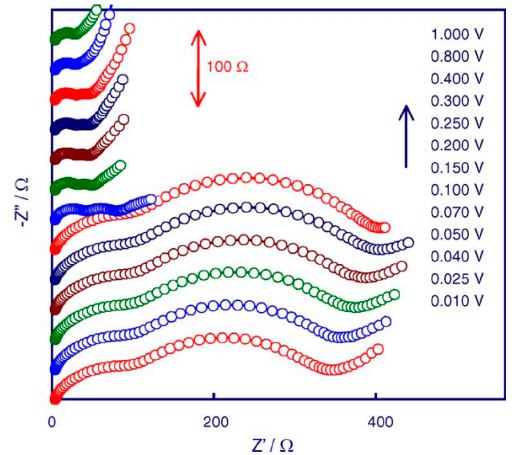
Figure 10. EIS of the lithium/graphite cell during the first delithiation of a cell [87]